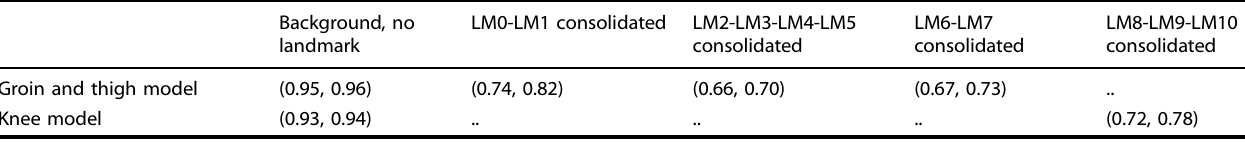
Table 2. Quantitative results for the landmark detection task of the used models.